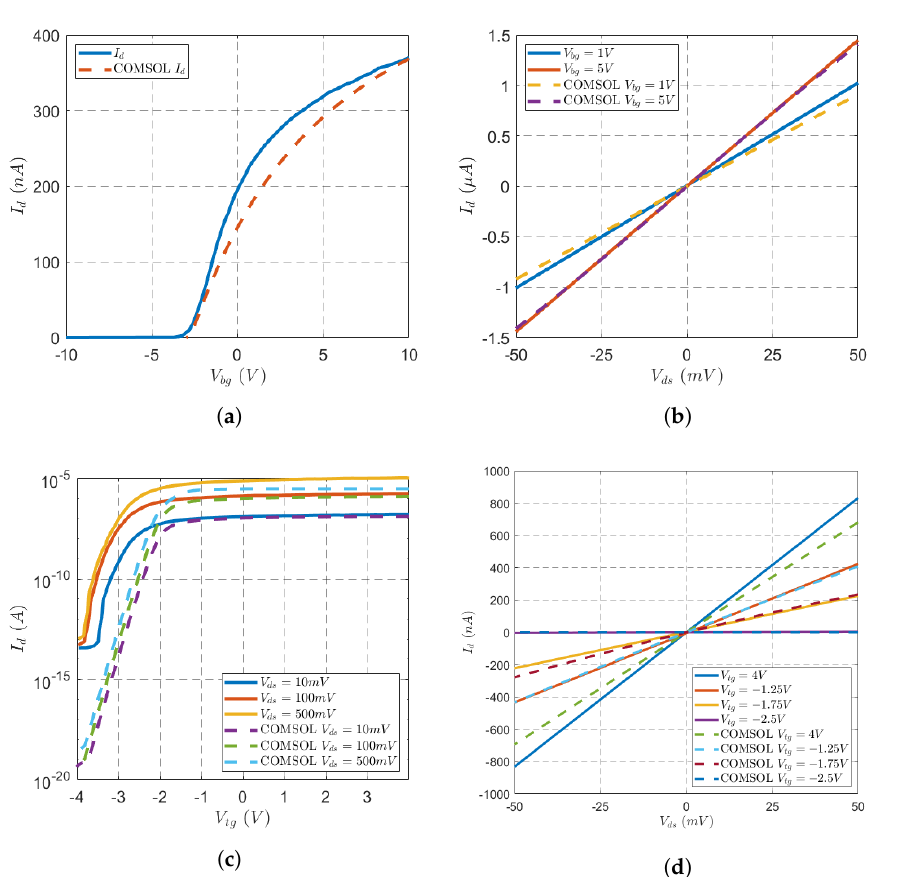
Figure 9. Results comparison between experimental (solid) and simulated (dashed) data. Transfer characteristic when V ds = 10 mV ( a ) and the top gate is disconnected. Output characteristic ( b ) with disconnected top gate. Transfer characteristic when V bg = 0 V ( c ). Output characteristic for different values of V tg and grounded back gate ( d